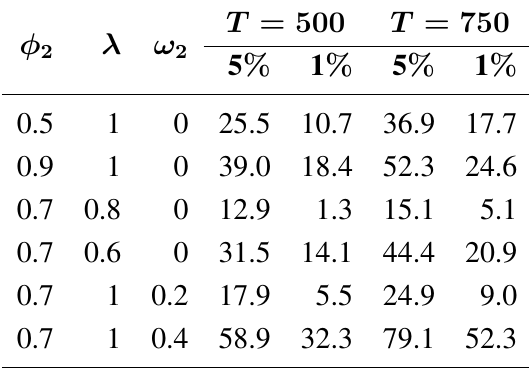
Table 2. Empirical power of the LM test by Monte Carlo